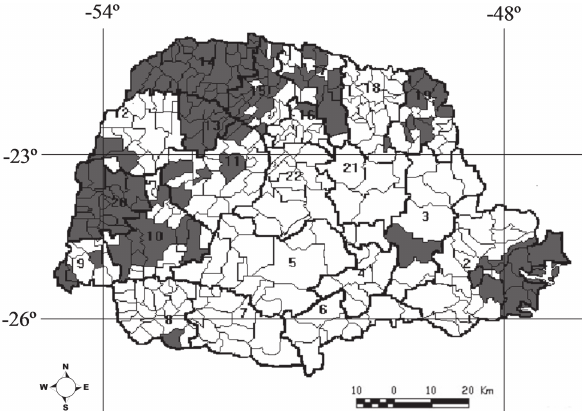
Figura 2. Mapa do estado do Paraná com os 132 municípios